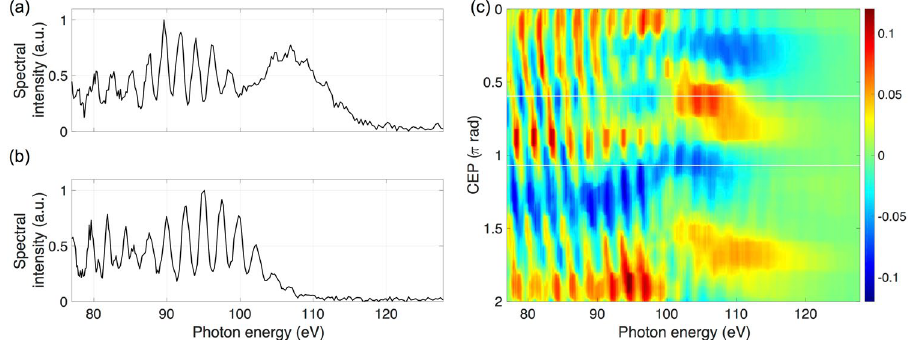
Figure 4. CEP-tagging demonstration. ( a,b ) Two single-shot XUV spectra at a relative CEP difference of π /2. The interference pattern in the spectral region above 100 eV disappears for ( a ). ( c ) Difference between spectral intensity and CEP-averaged spectrum, as a function of CEP. In the region below 100 eV a harmonic frequency shift is visible, corresponding to two complete harmonics within a 2 π change of the laser’s CEP. In the region above 100 eV, changes in the spectral intensity with respect to CEP are observed to have a π -periodicity. The white lines mark the two single-shots shown in ( a